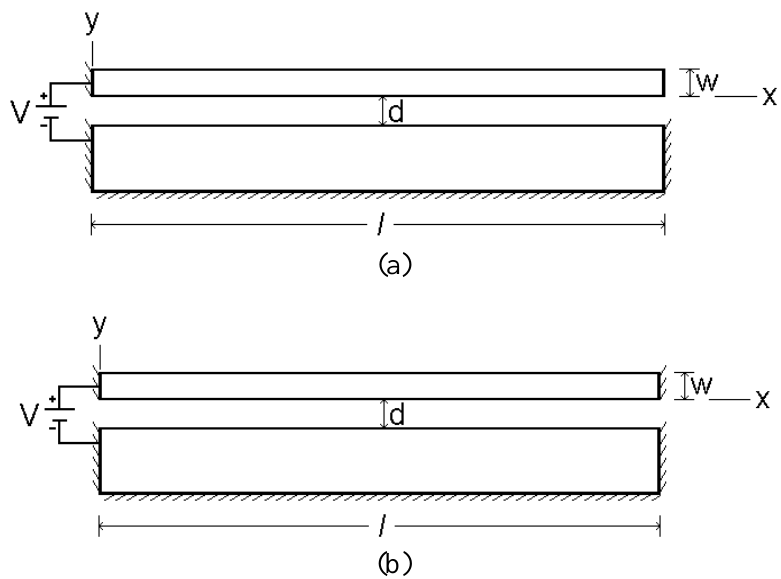
Figure 3. Beam profiles (a) cantilever beam (b) fixed-fixed beam.